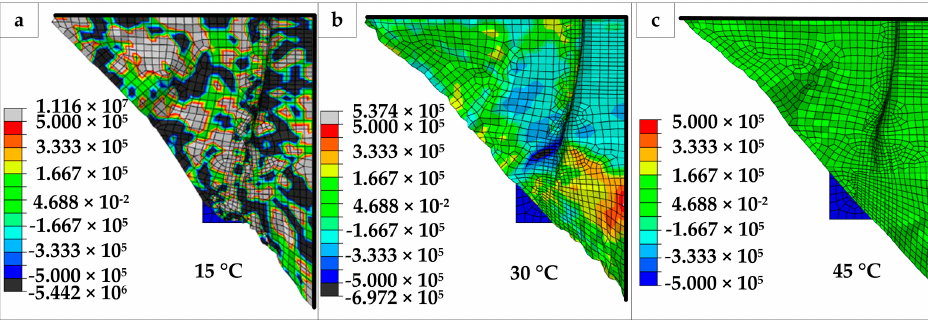
Figure 16. The shear stress distribution at different temperatures: ( a ) the top view of material at 15 °C; ( b ) the top view of material at 30 °C; ( c ) the top view of material at 45 °C.